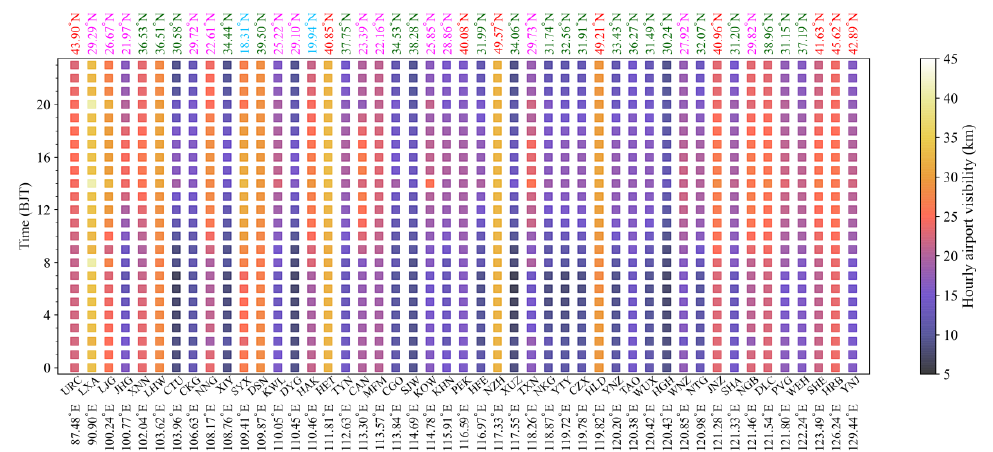
Figure 5. Intraday distribution of hourly visibility at 47 international airports during 2010 – 2020. The airports are arranged left-to-right by longitude along the x-axis. Light blue, pink, dark green and red represent airports located between 10 – 19° N, 20 – 29° N, 30 – 39° N and 40 – 49° N, respectively.